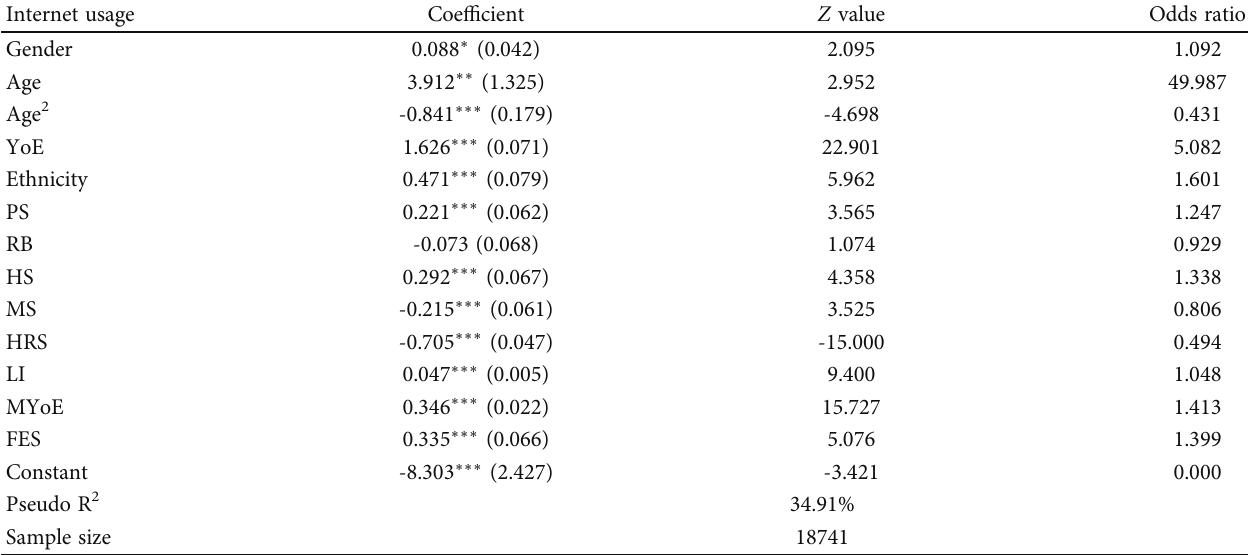
Table 2: Estimated results of the e ff ect of covariates on Internet